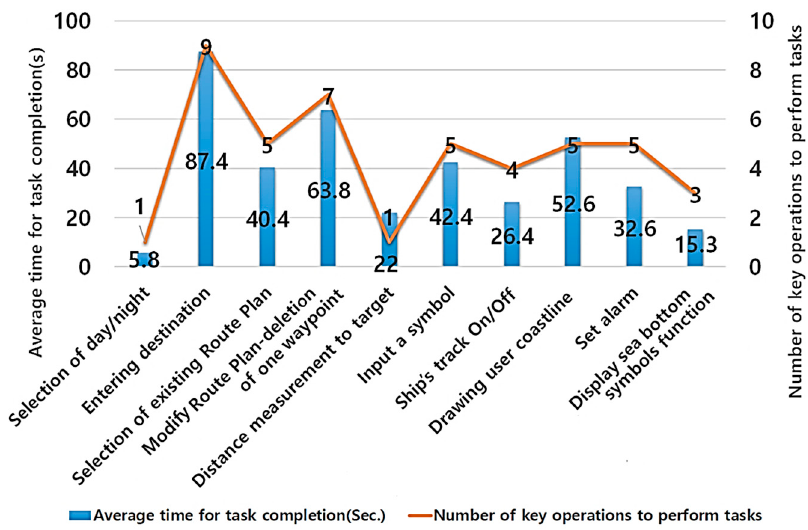
Figure A14. Result of user testing on performance of each